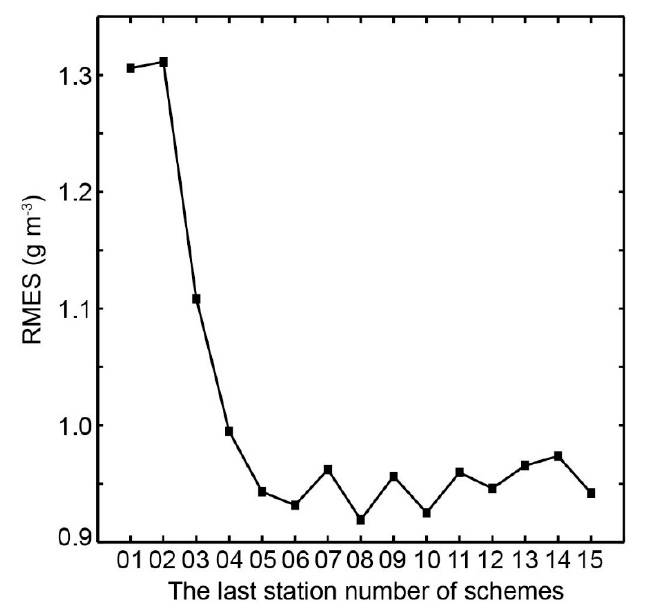
Figure 8. Root-mean-square error (RMSE) (black squares) of the fifteen GNSS tomographic schemes in the 31-day period; HKKP’s radiosonde data were used as the reference.